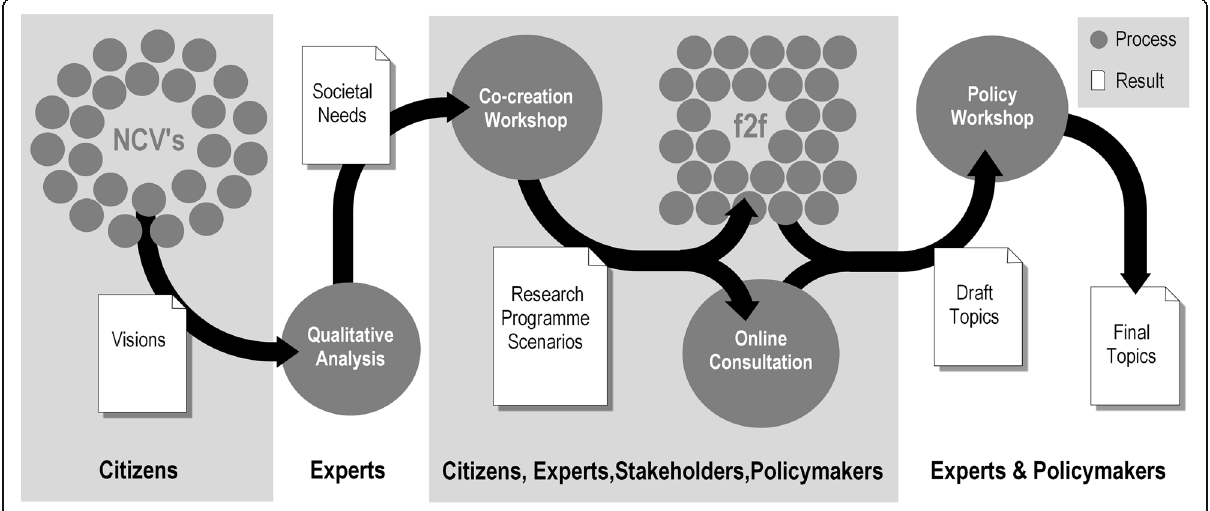
Fig. 1 CIMULACT methodology to co-create research topics